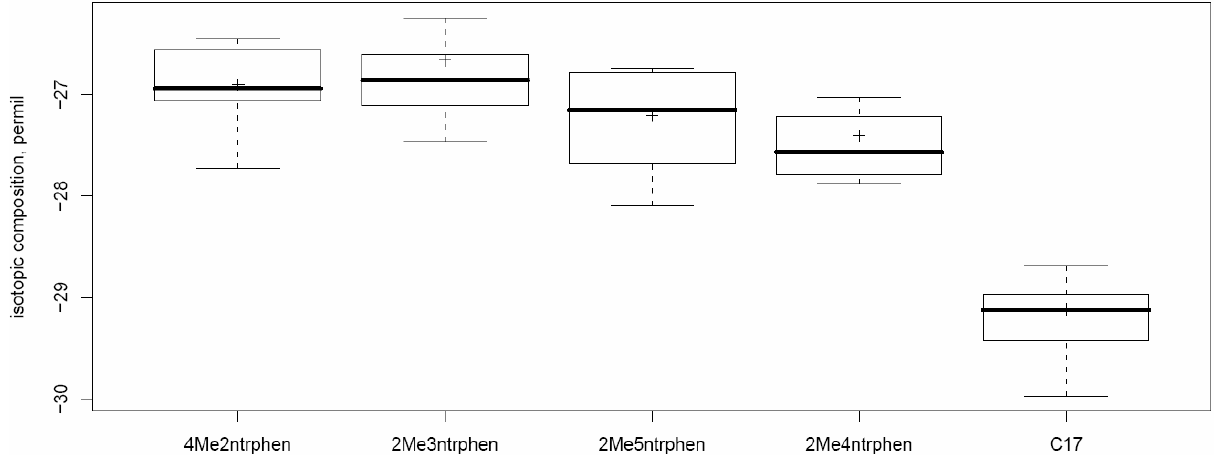
Fig. 3. Comparison of online and offline isotope ratio measurements for methylnitrophenols. (+) represents the offline value. The box plot represents GC-IRMS measurements of solutions containing between 1 to 20ngµl − 1 . The heavy lines give the median values, the boxes indicate the 25 and 75 percentile range and the upper and lower ends of the vertical bars the extreme values of the measurements. Table 4. Results of GC-IRMS analysis of 1µg of each compound spiked on blank filters. For comparison the results from off-line analysis of bulk material are also presented. Mass Test 1 Test 2spiked on a blank filter Offline Online